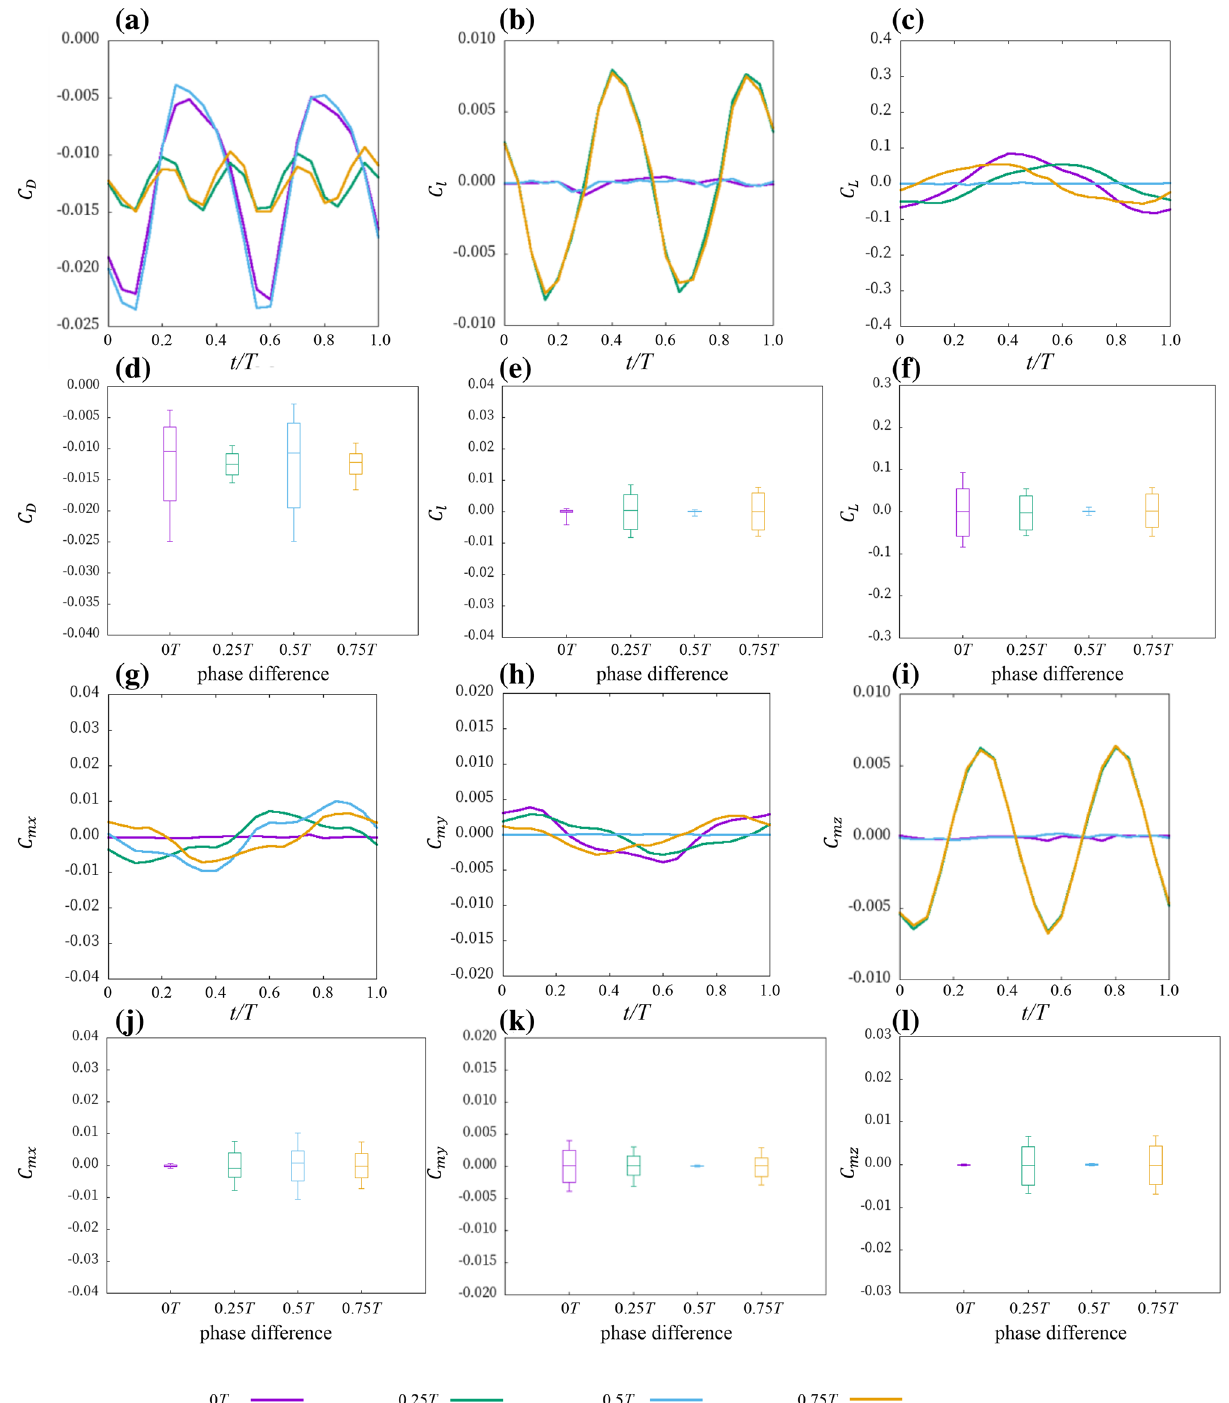
Figure 3. Instantaneous forces during one pectoral fin beat cycle of D. acutirostra forward swimming and Box-plot graph. ( a , d ) Drag coefficient, ( b , e ) lateral force coefficient, ( c , f) lift coefficient, ( g , j ) moment coefficient around the x -axis, ( h , k ) moment coefficient around the y -axis, and ( i , l ) moment coefficient around the z